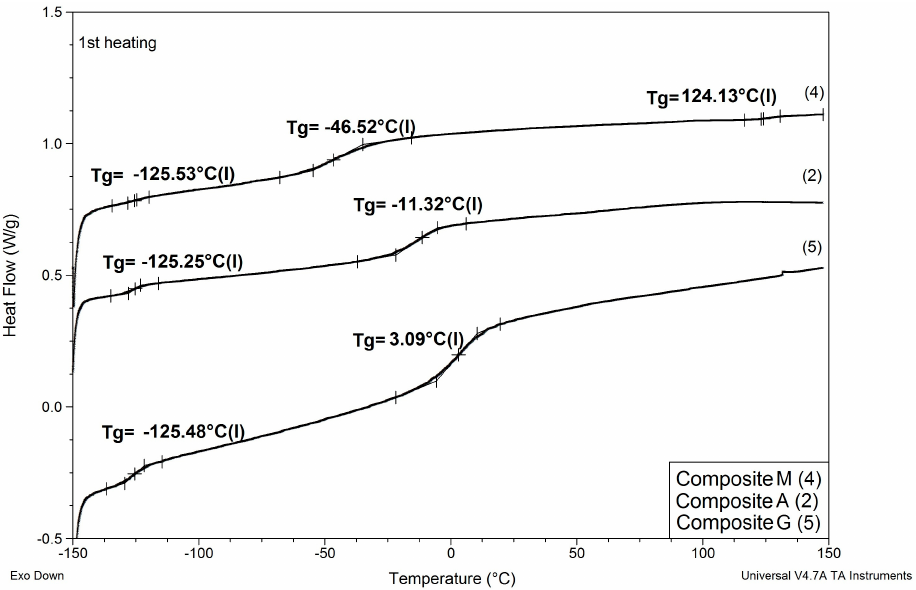
Figure 7. Comparison of DSC patterns obtained for composite A prepared without any IL and composites G and M, where 20% of PSUR prepolymer was replaced with reactive IL 3, and lithium salt was dissolved, respectively, in EC/DMC (like in A) and in non-reactive IL 5.